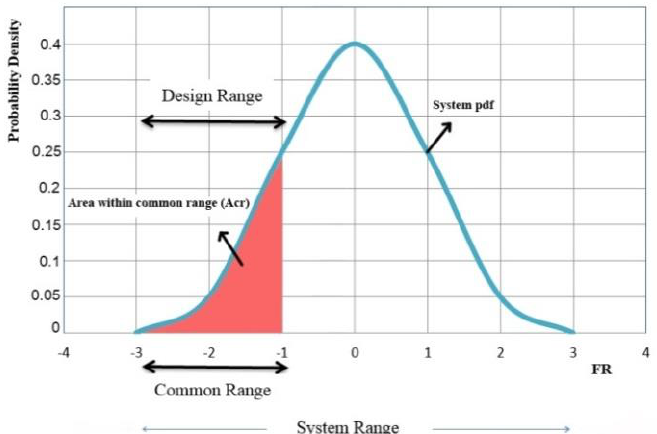
Figure2. Continuous density function for the system range and the uniform function for design